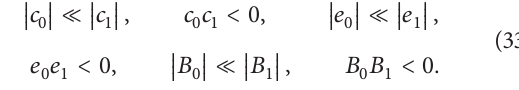
respectively. = (2, −1) , 𝑆 𝑆 3